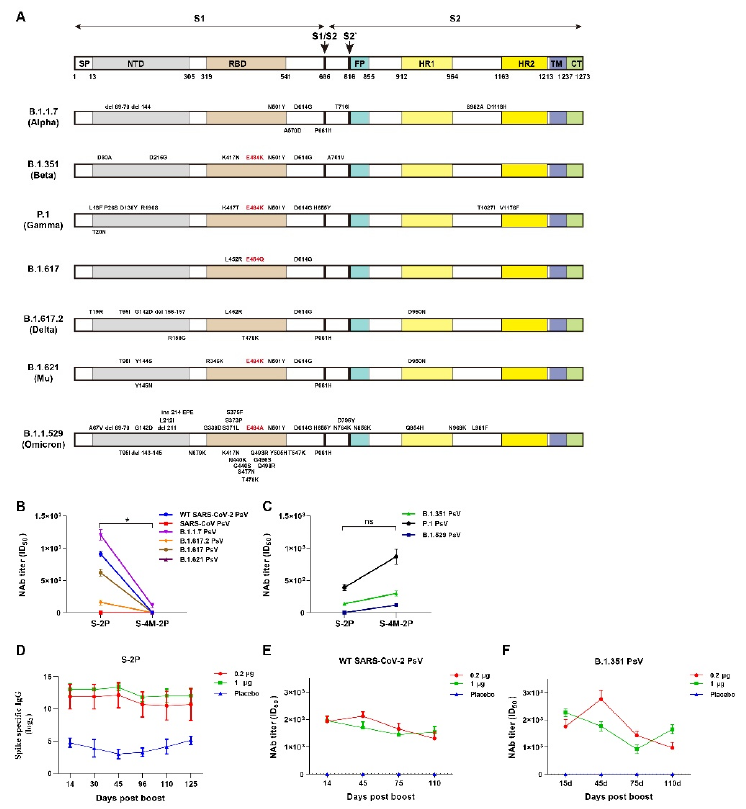
Figure 4. Neutralizing antibodies elicited by S ‐ 4M ‐ 2P mostly targeted the variants carrying E484K mutation. ( A ) Schematic illustration of structural components of spike protein of SARS ‐ CoV ‐ 2 and respective mutations in the spike protein of B.1.1.7, B.1.351, P.1, B.1.617, B.1.617.2, B.1.621, and B.1.1.529 SARS ‐ CoV ‐ 2 variants. Mutations at site 484 are marked in red. Neutralization titer (ID 50 ) of boost sera from S ‐ 2P ‐ or S ‐ 4M ‐ 2P ‐ vaccinated mice against SARS ‐ CoV, wild ‐ type, and SARS ‐ CoV ‐ 2 variant pseudotyped viruses without E484K mutation ( B ) or with E484K mutation ( C ). Data are shown as mean ± SEM, representative of two independent experiments with 2 replicates. ( D ) Sera from S ‐ 2P ‐ immunized mice were collected at the indicated time points, and SARS ‐ CoV ‐ 2 spike ‐ spe ‐ cific IgG titers were determined by ELISA. Sera from the S ‐ 2P ‐ immunized mouse group were col ‐ lected at the indicated time points and mixed together in equal quantities, and neutralization titers (ID 50 ) against WT SARS ‐ CoV ‐ 2 ( E ) or B.1.351 variant ( F ) pseudovirus were assayed. Data are shown as mean ± SEM, representative of two independent experiments with two replicates. * p < 0.05, ns: not significant.